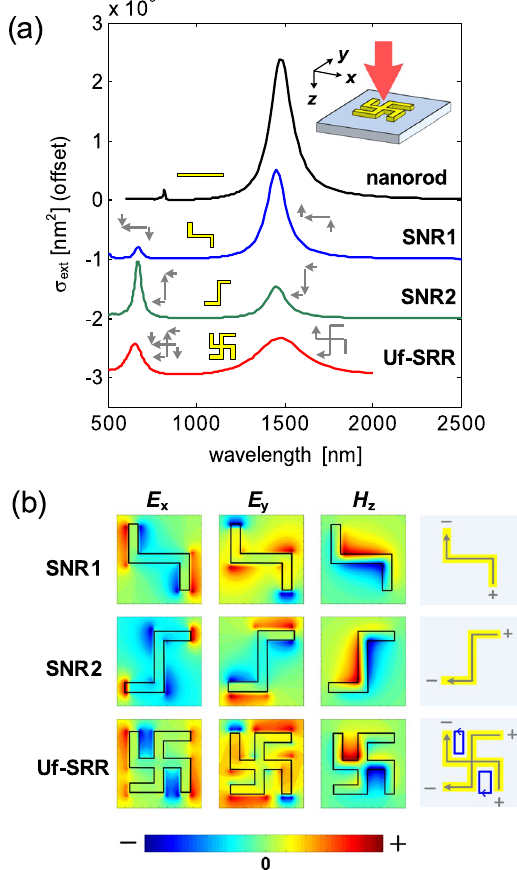
The arm length of the Uf-SRR is s = 60 nm, and the length of the nanorod is adjusted to have the same total length of the SNR, i.e., L = 4 s . ( b ) The electromagnetic field distributions of the S NRs and Uf-SRR with the indicated electric dipoles (gray) and circulating currents